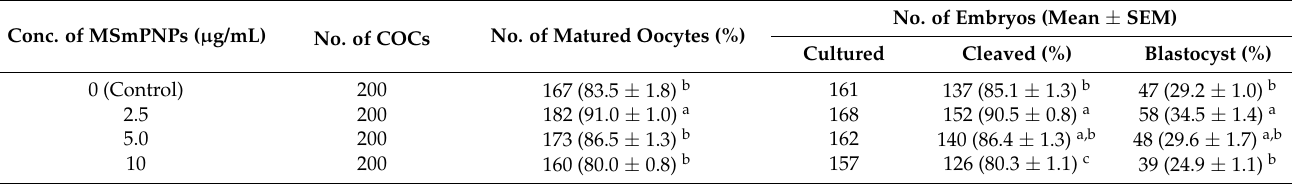
Table 2. Effect of in vitro maturation of porcine oocytes with different concentrations of MSmPNPs on the in vitro develop- ment rate of PA